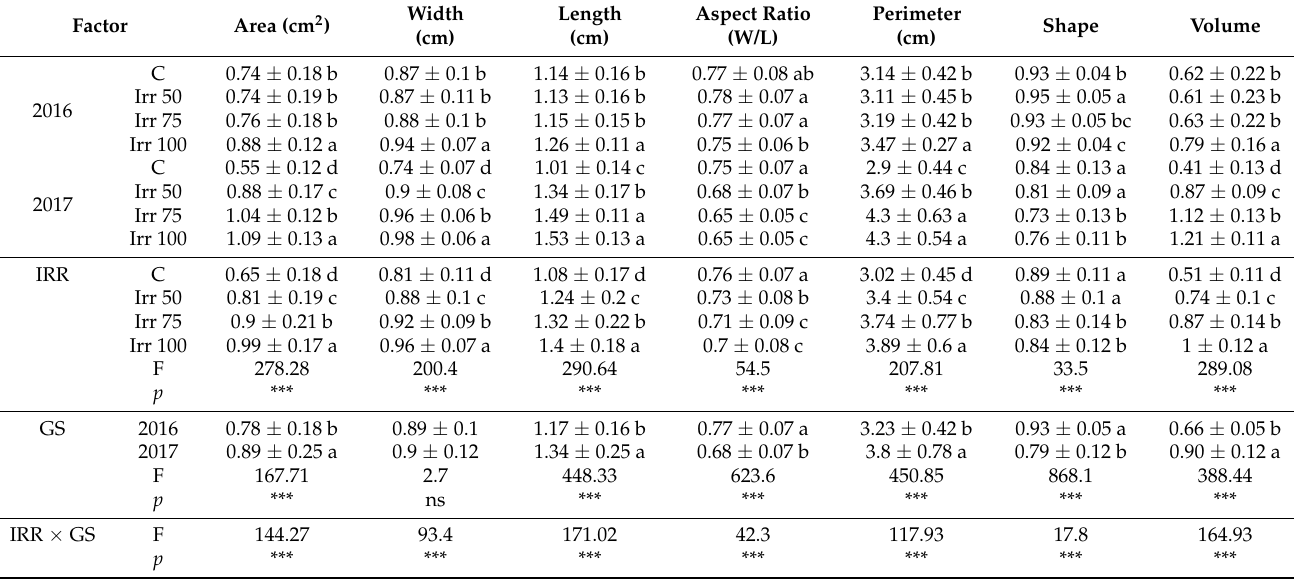
Table 3. Effect of different irrigation levels on olive stone parameters during two experimental